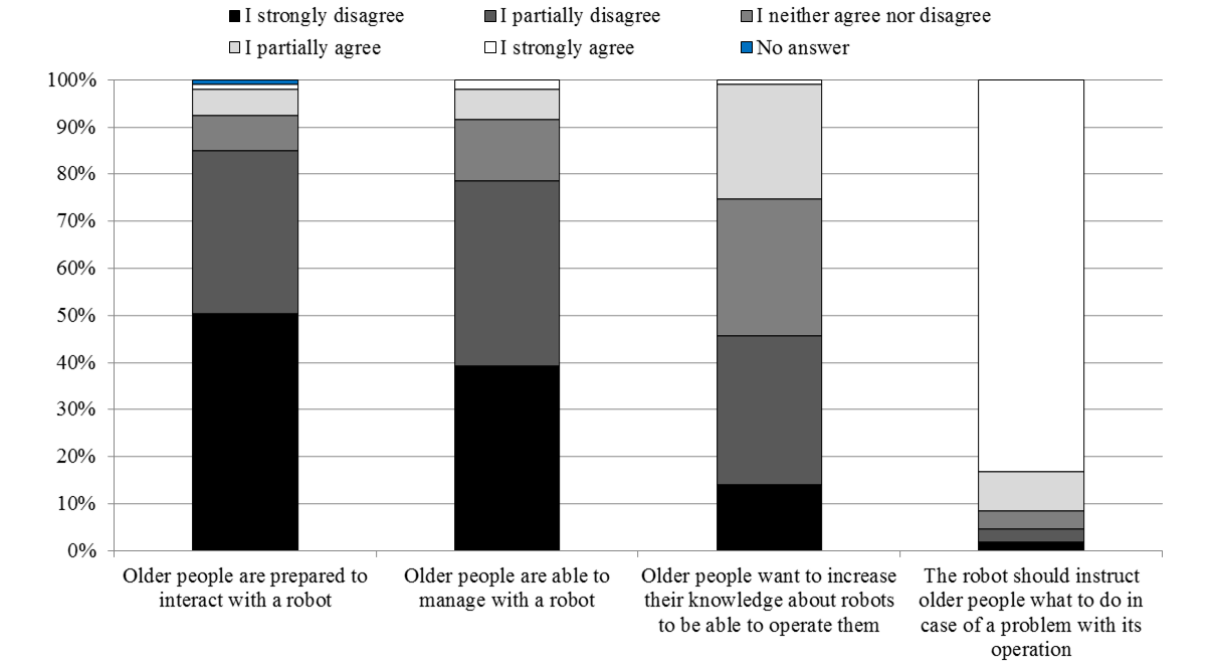
Figure 1. Opinions of the whole group of students about the readiness of older people to use a